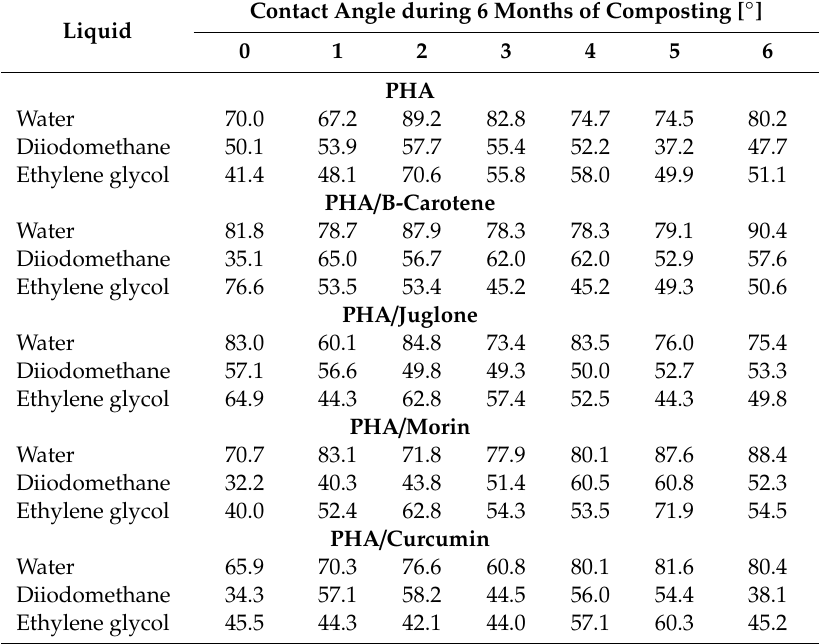
Table 2. Contact angle obtained using water, diiodomethane, and ethylene glycol for PHA samples during 6 months of